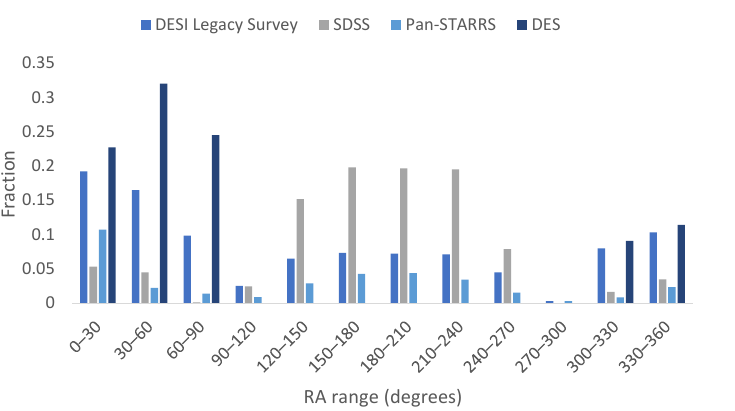
Figure 2. The distribution of the galaxies imaged by DES, DESI Legacy Survey, SDSS, and Pan- STARRS in different 30° RA ranges.